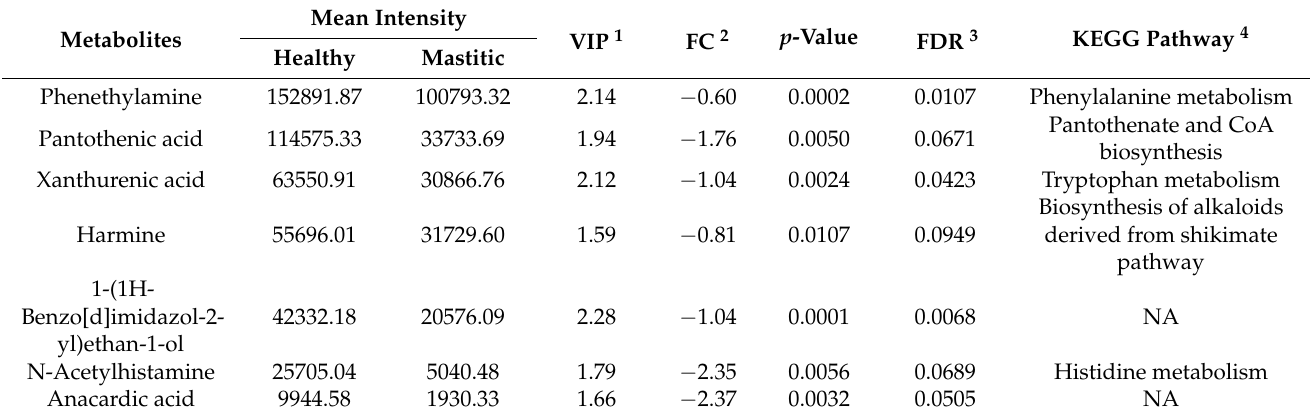
Table 1. Characterization of differential ruminal metabolites in healthy and mastitic cows by HPLC-MS/MS. Metabolites